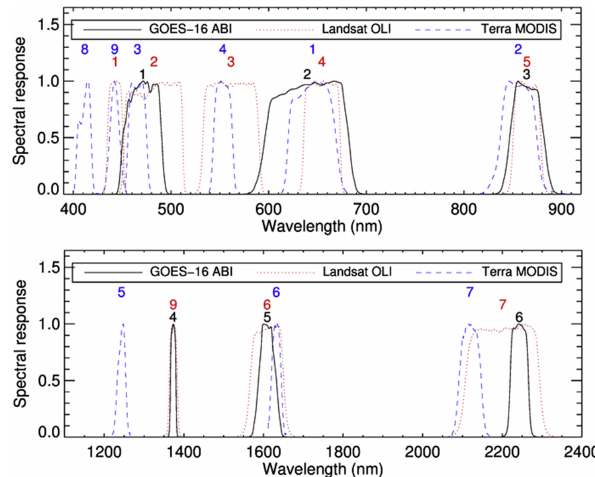
Figure 1. A comparison of the spectral sensitivity of the Advanced Baseline Imager (ABI) with the Landsat Operational Land Imager (OLI) and MODIS Terra (McCorkel et al.,